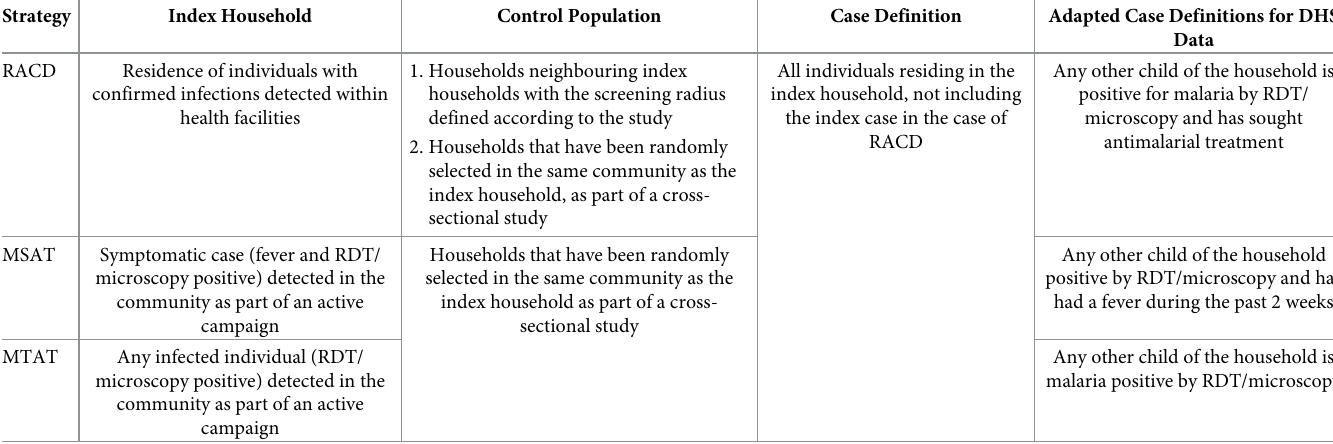
Table 1. Overview of programmatic strategies for identifying households likely to have asymptomatic and/or subpatent infections.